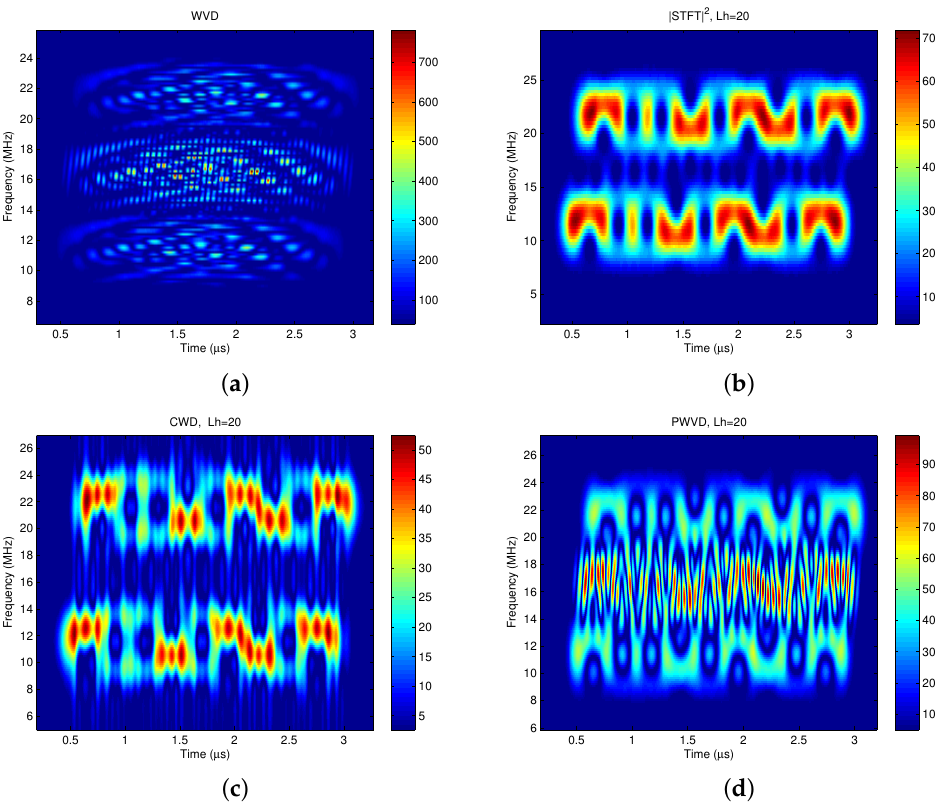
Figure 1. The time frequency distribution of a 4-QAM pulse shaping signal. ( a ) WVD; ( b ) STFT; ( c ) CWD; ( d )